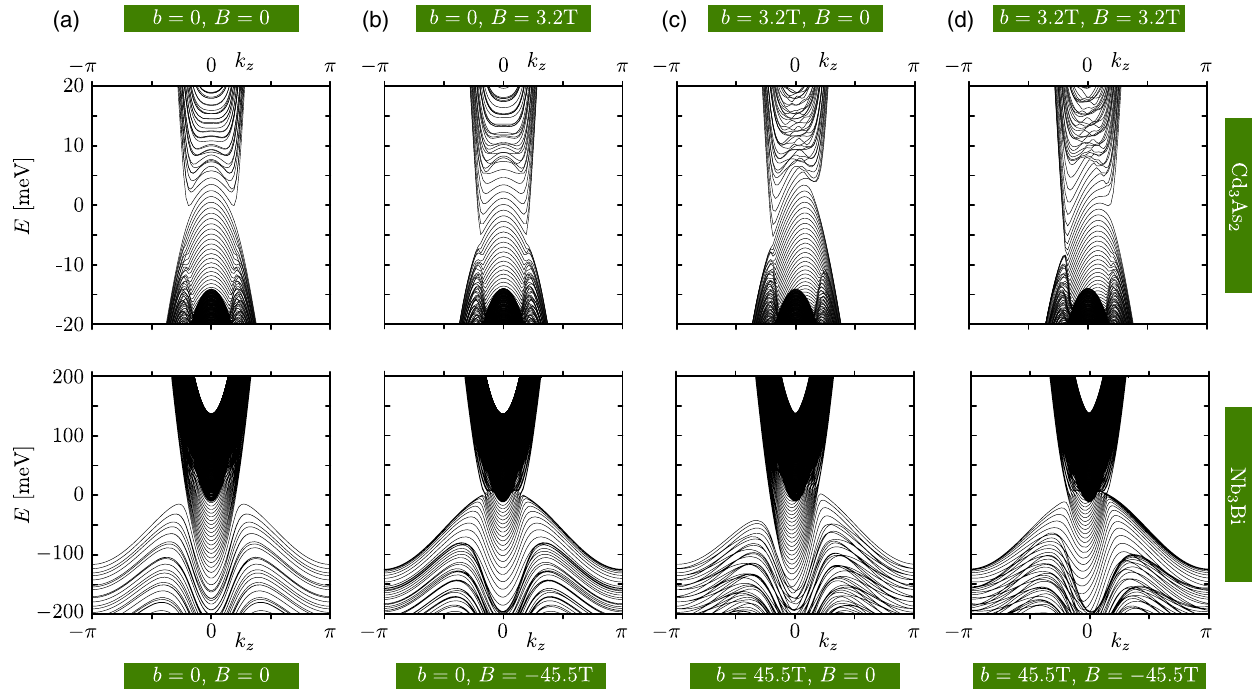
FIG. 9. Dispersion relations for the spin-up sector of the lattice Hamiltonian (2.3) describing Cd 3 As 2 (top row) and Na 3 Bi (bottom row). The parameters used in the simulations include the particle-hole symmetry-breaking terms and are summarized in Table I. We used a lattice with 40 × 40 sites and the magnetic fields shown in the green boxes for each of the materials. Notice the different magnitude of effective magnetic fields for different compounds — this is due to the different lattice constants and a different sign of the physical magnetic field between the two rows. A different sign of magnetic fields shows that the physical magnetic field compensates the torsional one in opposite Weyl points for opposite directions of the magnetic field in accordance with the interpretation in the